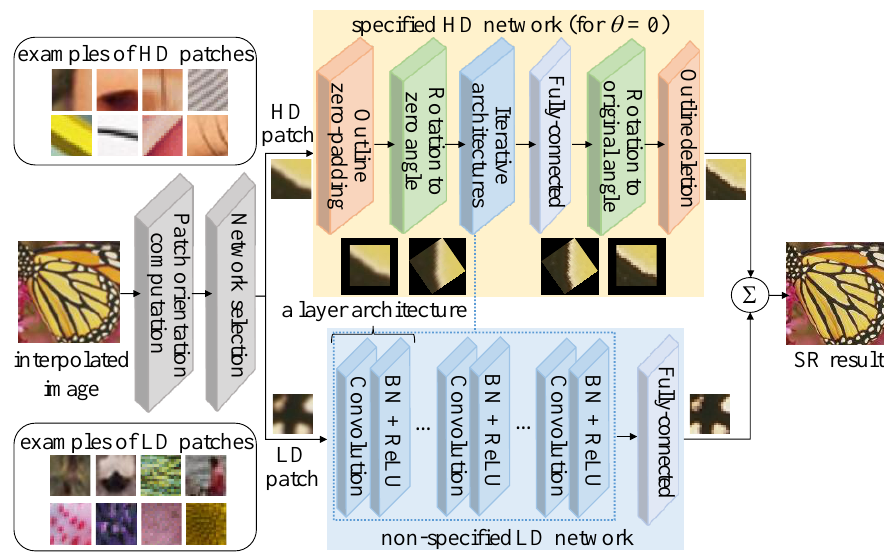
Figure 13. Architecture of the patch orientation-specified network [10].